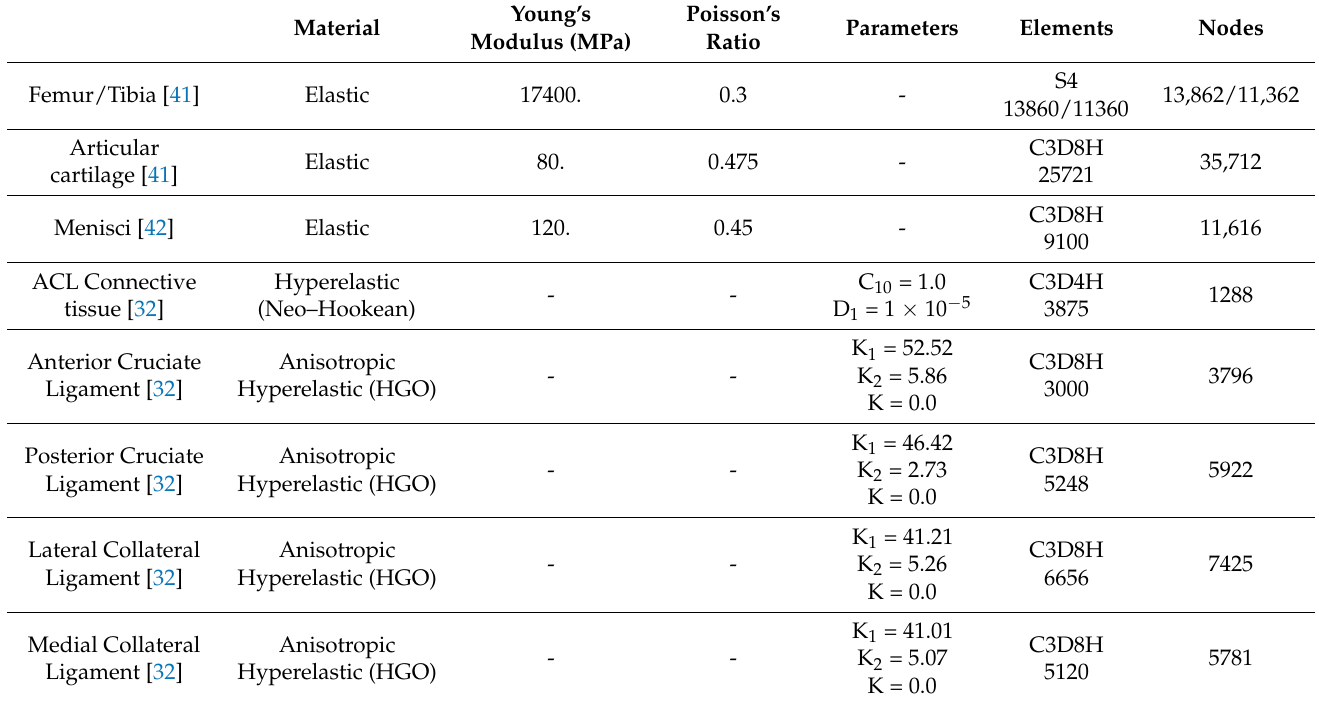
Table 1. Material